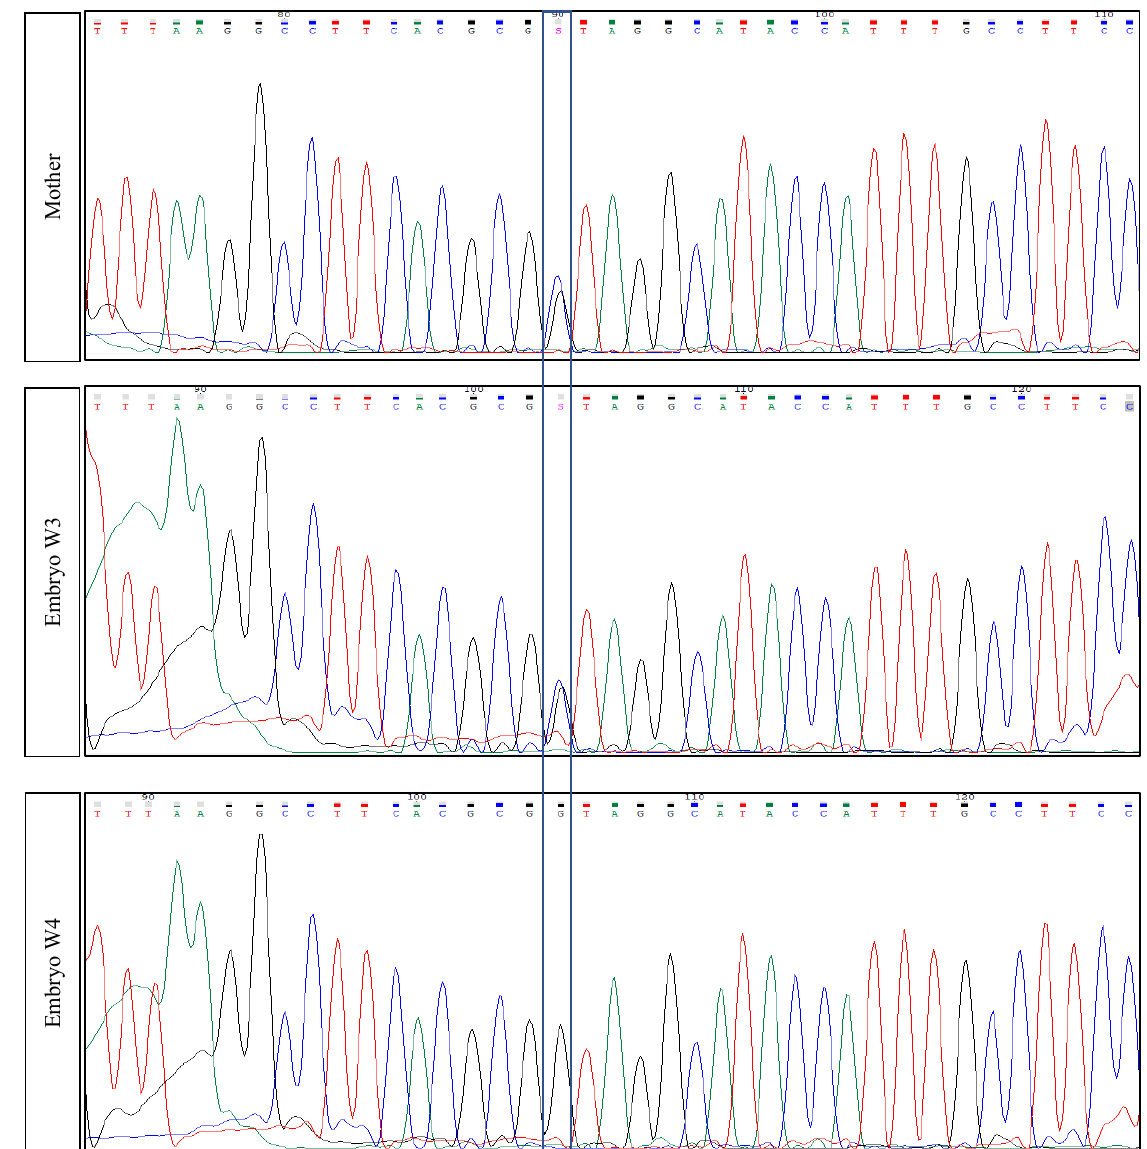
Figure 1. Electropherograms following Sanger sequencing in both parents and offspring; embryo(s) W3 and W4 did not possess the father’s mutation. W3 embryo possesses the mother’s mutation in contrast with the W4 embryo that was transferred.